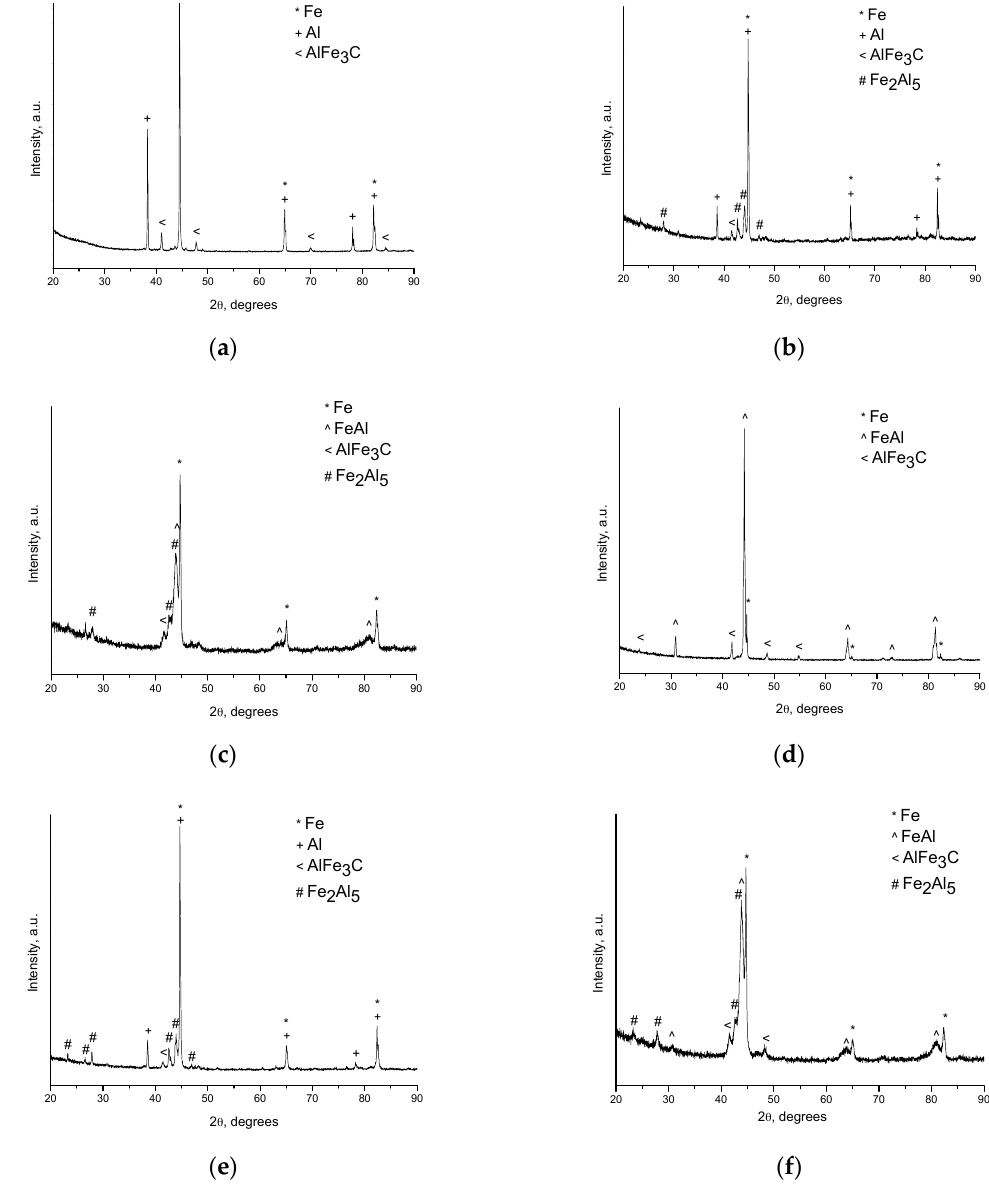
Figure 2. XRD patterns of the porous compacts obtained from Fe-40at.%Al mixtures by pressureless SPS at ( a ) 500 ˝ C (green density 65%); ( b ) 600 ˝ C; ( c ) 600 ˝ C (green density 65%); ( d ) 650 ˝ C and by the hot pressing technique at ( e ) 650 ˝ C, pressureless experiment; ( f ) 650 ˝ C, applied pressure 3